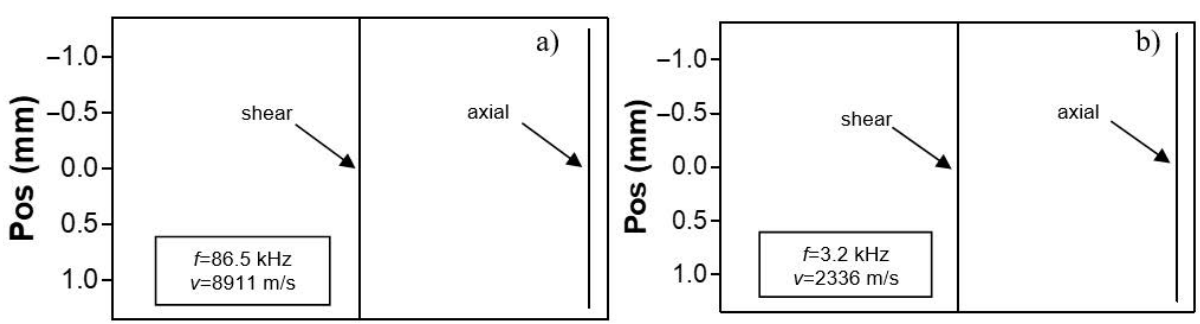
Figure 9. Identical strain distributions with depth calculated for s 0 modes in 0 ◦ ( a ) and 90 ◦ ( b ) directions of UD-CFRP at different frequencies.